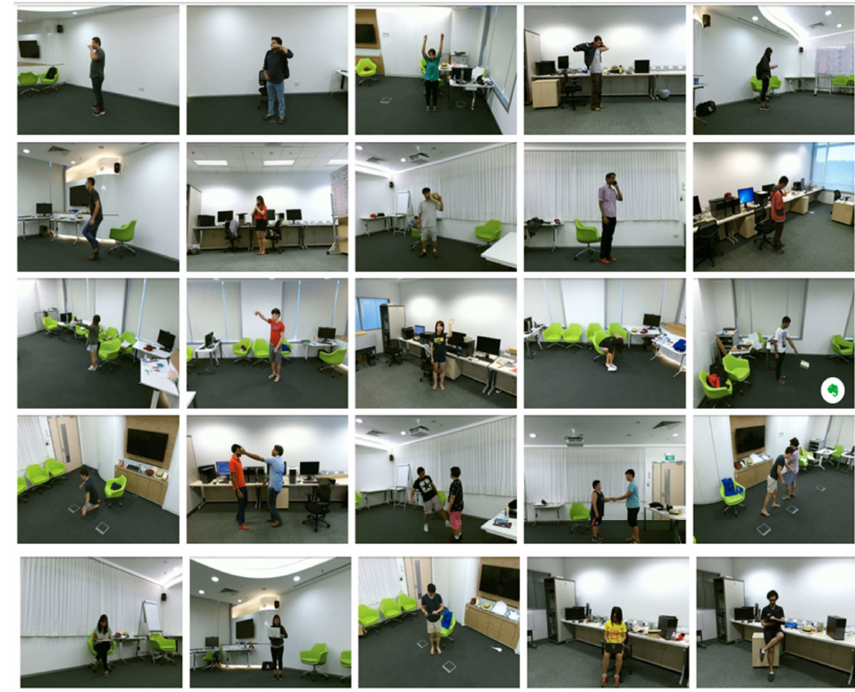
Figure 1. Sample images from NTU RGB+D dataset [50].